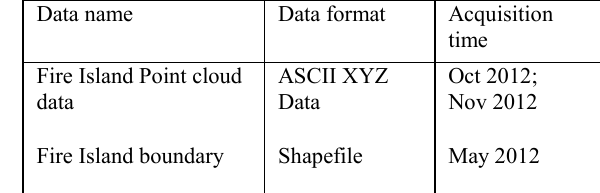
Table 1. Data information.